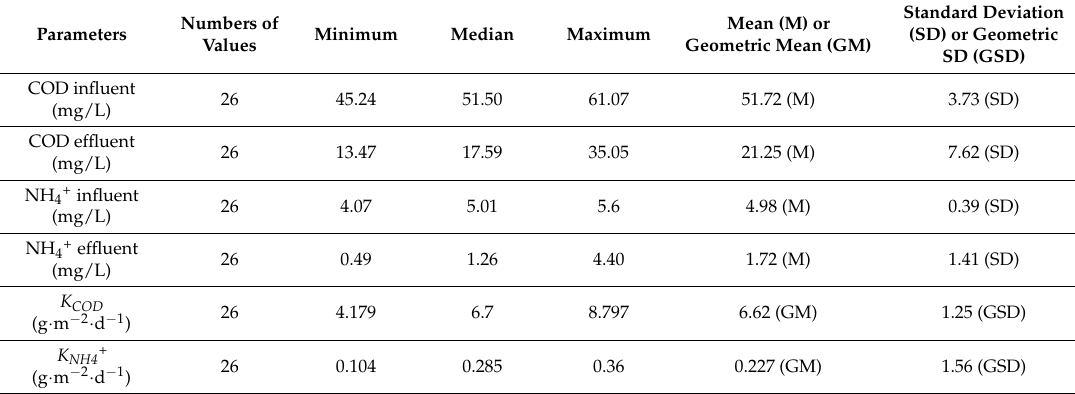
Table 1. Influent, effluent, and K values of COD and NH 4+ for LSCW